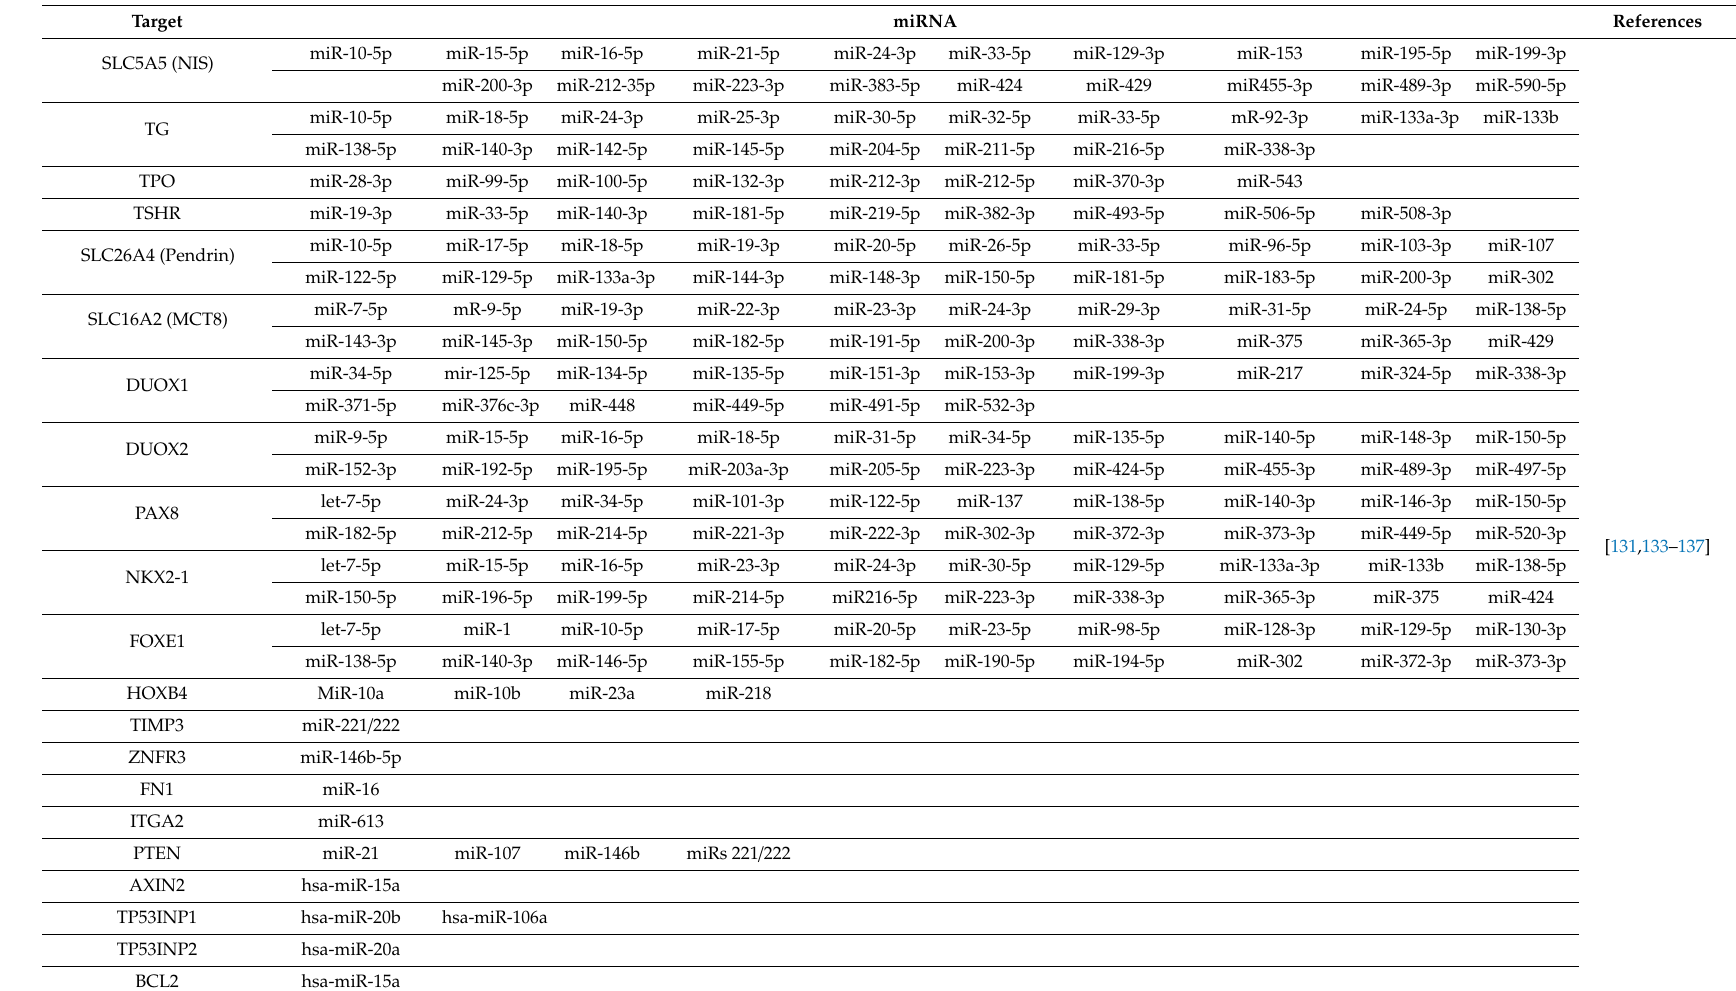
Table 3. Targets of microRNAs: di ff erent genes and transcription factors have been described as targets of miRNAs.